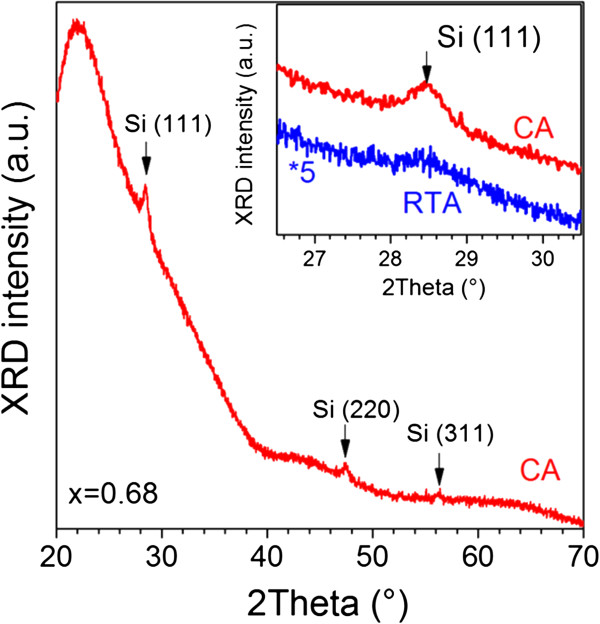
The XRD patterns of the samples submitted to CA and RTA treatments. XRD pattern for a sample with x = 0.68 after CA treatment at 1,150°C for 30 min in nitrogen flow. The inset shows the expanded presentation of the (111) Si peak for CA and RTA samples with x = 0.68. RTA treatment was performed at 1,050°C for 1 min in nitrogen flow.